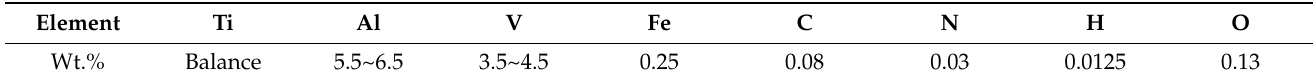
Figure 1. Microstructure and particle size distribution of TC4 powder. ( a )Powder morphology; ( b ) Percentage of powder particle size. Table 1. Chemical compositions of the TC4 titanium alloy powder.